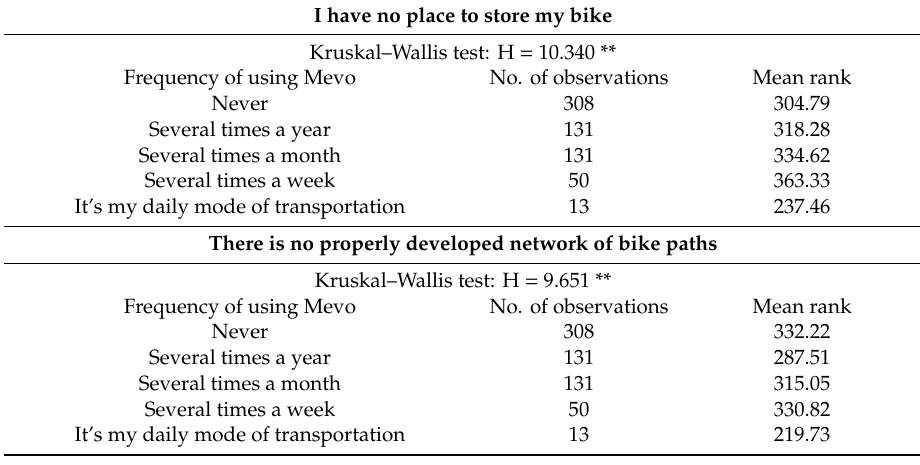
Table 3. Obstacles influencing the decision to ride a conventional bike and frequency of using the Mevo public bike system—Kruskal–Wallis